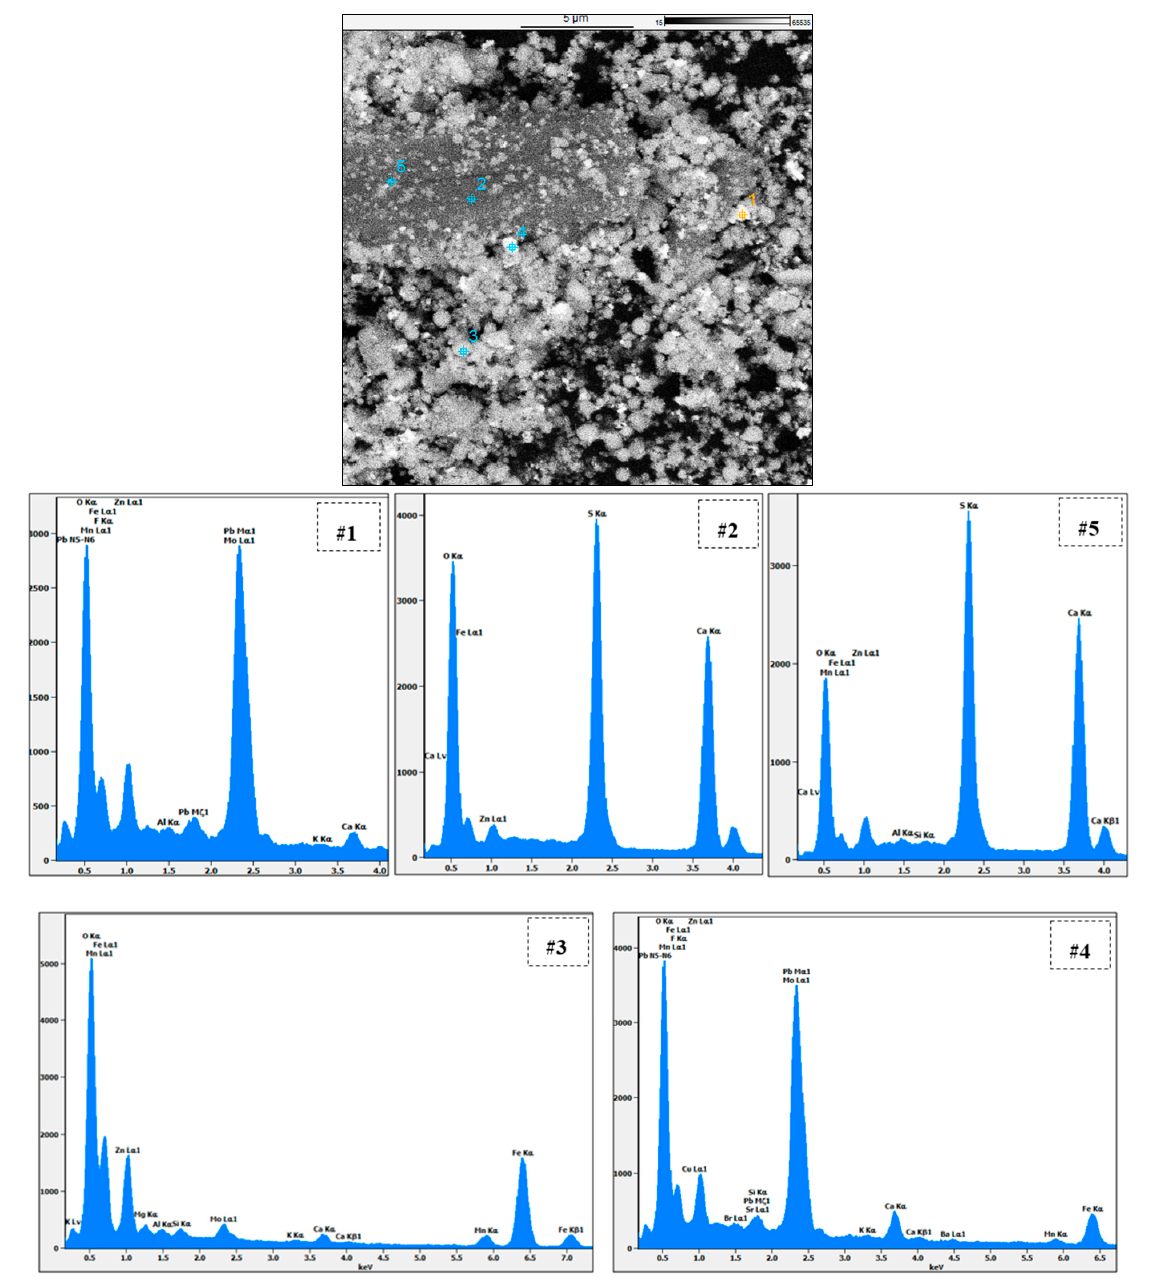
Figure 21. Point analysis with SEM-EDS of the EAFD leach residue in 30% v/v [Bmim + HSO 4 − ] at 85 °C. Table 4. Chemical composition of the selected points (1 to 5) on the EAFD residue leached in 30% v/v [Bmim + HSO 4 − ] at 85 °C.